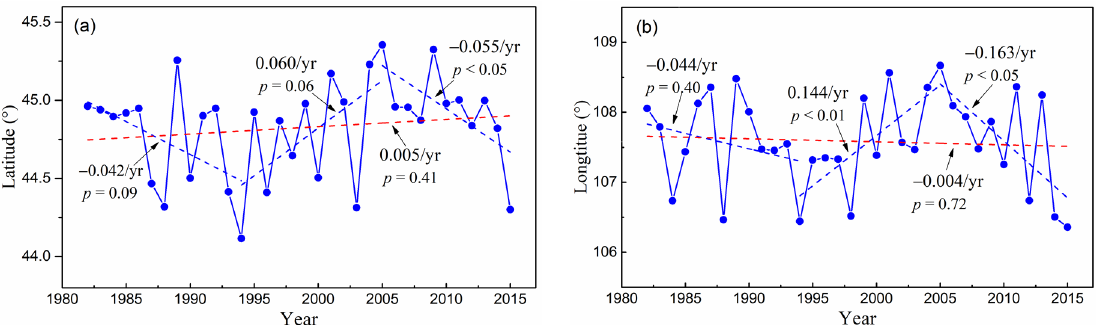
Figure 6. Changes in the latitude ( a ) and longitude ( b ) of the center point of the vegetation greenness line in ASTZMP during 1982–2015.